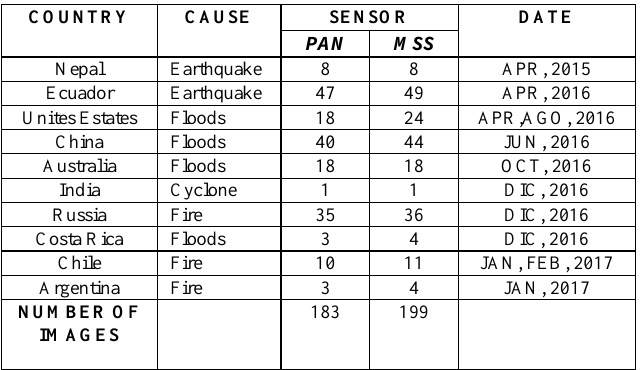
IMAGES PROVIDED TO DIFFERENT